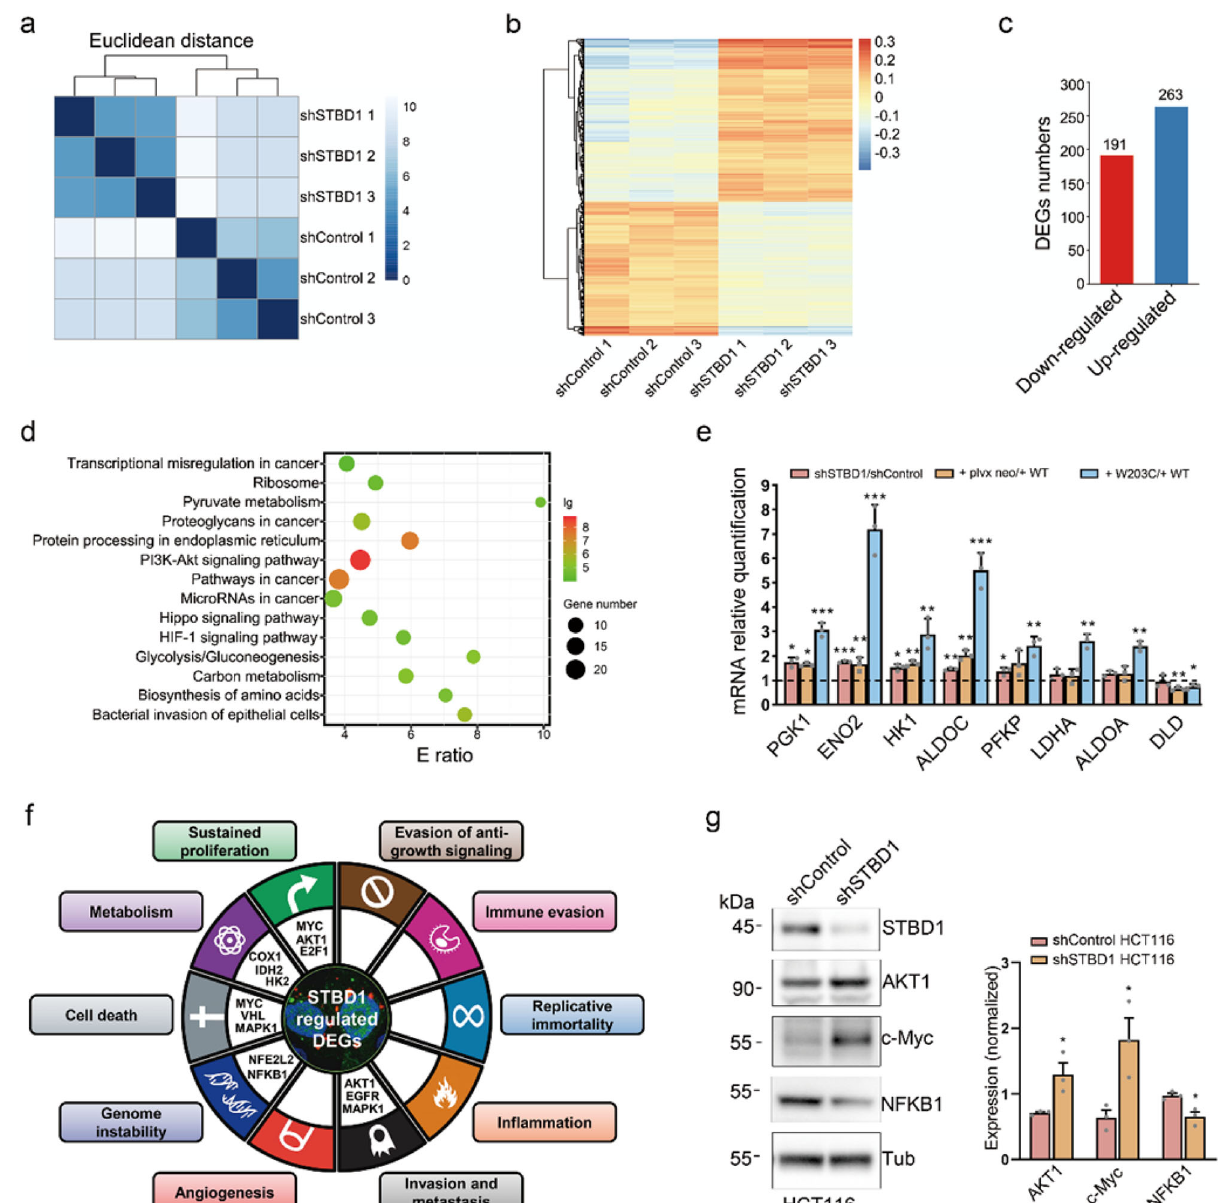
Fig. 5 Depletion of STBD1 alters multiple genes critical for glycolysis. a Three biological replicates of shControl and shSTBD1 HCT116 cells were clustered together in RNA-seq. b Heatmap of differentially expressed genes in shControl and shSTBD1 HCT116 cells. c The numbers of down-regulated or up- regulated genes in differentially expressed genes. d The KEGG-based enrichment analysis of biological pathway of differentially expressed genes. e mRNA levels of several genes responsible for glycolysis were determined by RT-PCR and normalized using TUBB mRNA. These relative mRNA levels in shSTBD1 vs. shControl HCT116 cells, shSTBD1/W203C vs. shSTBD1/WT cells, and shSTBD1/WT vs. shSTBD1/plvx neo cells were shown. f Enrichment analysis of cancer hallmark traits affected by STBD1 depletion. Representative hallmark genes are shown in the circle. g Protein levels of STBD1, AKT1, c-Myc, and NFKB1 (p50) in shControl and shSTBD1 HCT116 cells were determined by immunoblotting and normalized using Tubulin or GAPDH. Experiments in e , g were performed in triplicate. Statistical data are presented as mean ± SD. Statistical comparisons were performed using an unpaired t test. *** p < 0.001, ** p < 0.01, * p <